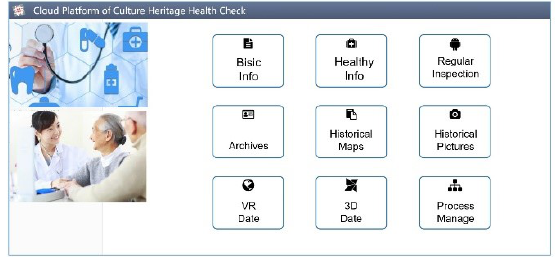
Figure 7: Diagram of cultural heritage health management and